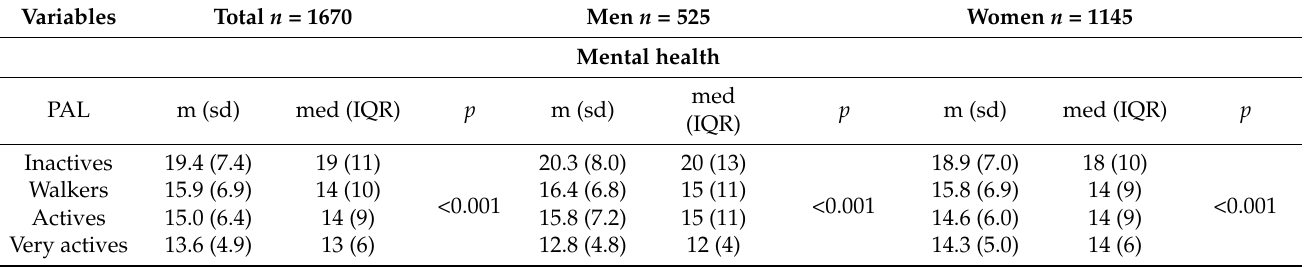
Table 2. Associations between the Goldberg General Health Questionnaire dimensions (GHQ-12), and PAL in Spanish adults with psychological distress, according to the ENSE